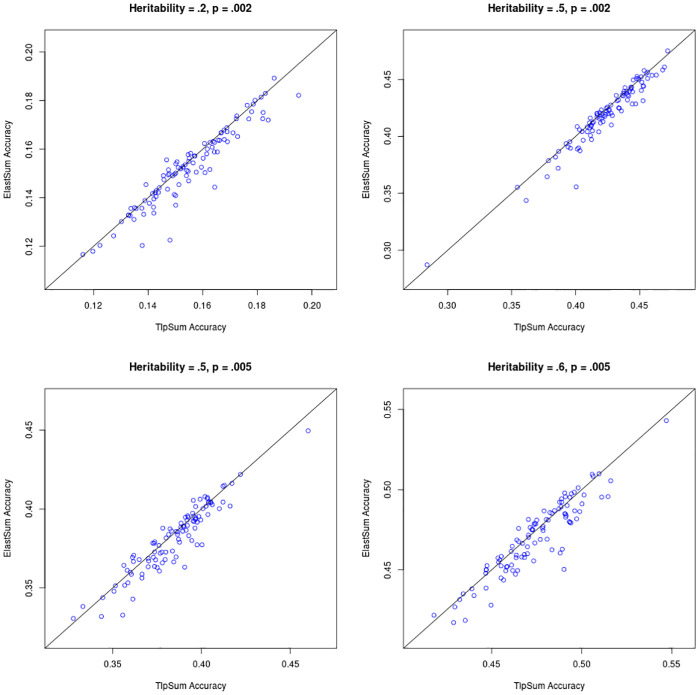
Predictive r2 on out-of-sample data for TlpSum and ElastSum for each of the 100 replications at each of the four simulation settings.Lines are at a 45 degree angle through the origin, and not a line of best fit. Points below the line indicate better performance of TlpSum.